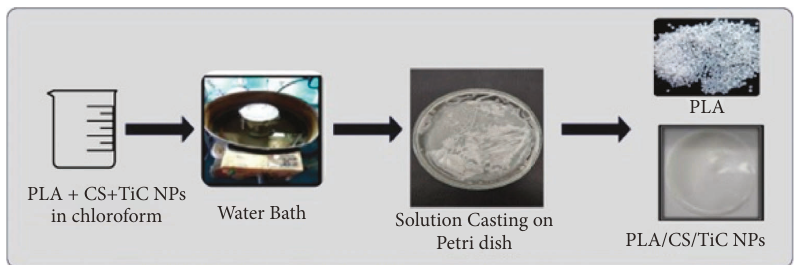
Figure 1: Synthesis of polylactic acid/chitosan/titanium carbide